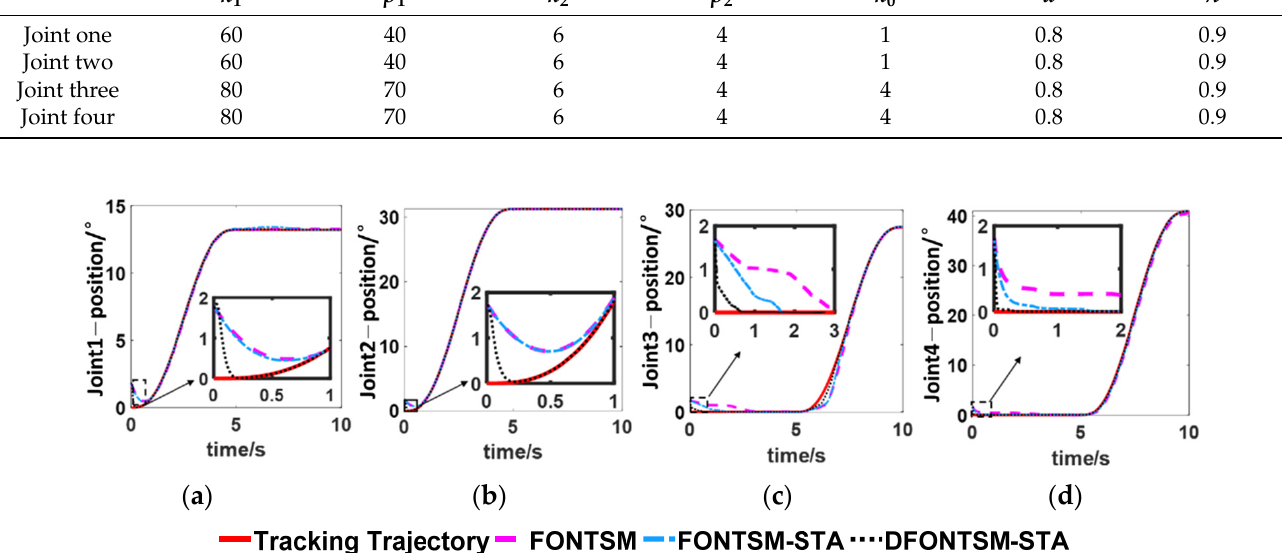
Figure 2. Position tracking trajectory of each joint. ( a ): joint one; ( b ): joint two; ( c ): joint three; ( d ): joint four.